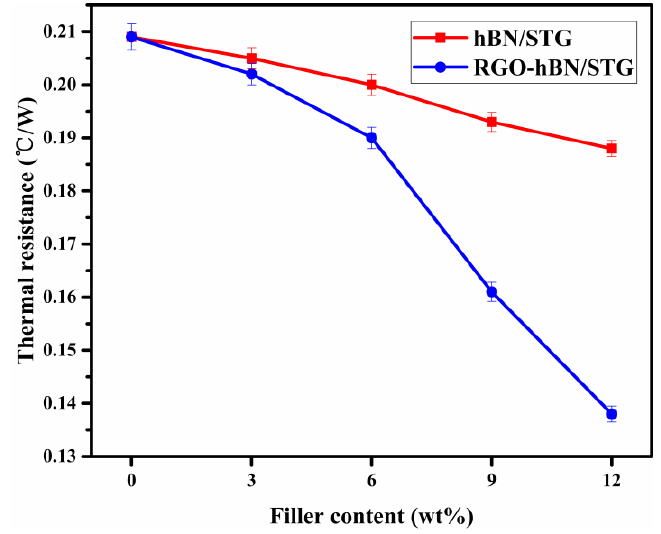
Figure 6. Thermal resistance of hBN/STG and RGO- hBN/STG with different filler contents .